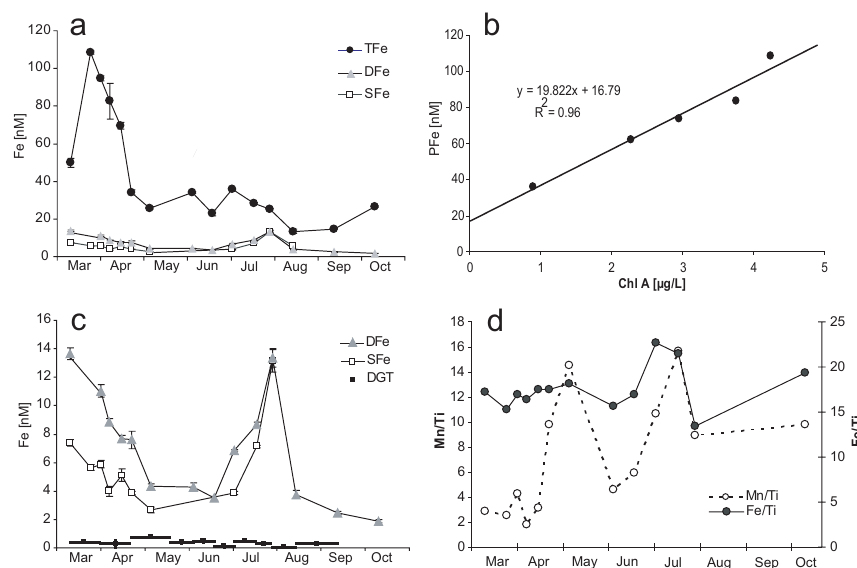
Fig. 8. Landsort Deep station (BY31) 2004. Concentrations TFe (total Fe), DFe ( < 0.22µm)and SFe ( < 1kDa) (a) . Regression between unfiltered Fe and Salinity at 5m depth, the five first sampling occasions (b) . Concentrations of DFe( < 0.22µm), SFe( > 1kDa) and DGT- labile Fe ([Fe] DGT ) (c) . For DGT measurements, the vertical lines indicate the time period for the measurement, and the filled square represent the mid-date. Temporal variations of Mn/Ti and Fe/Ti in the suspended phase at 5m depth (d) .